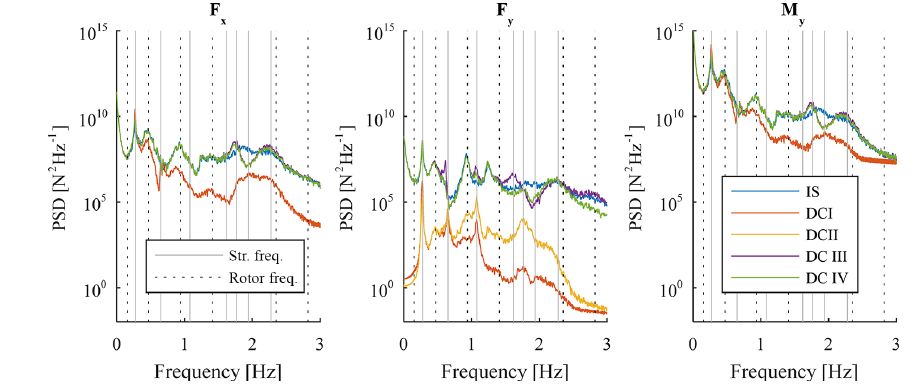
Figure 20. PSD for forces and moment at tower bottom for wind speed of 8ms − 1 .